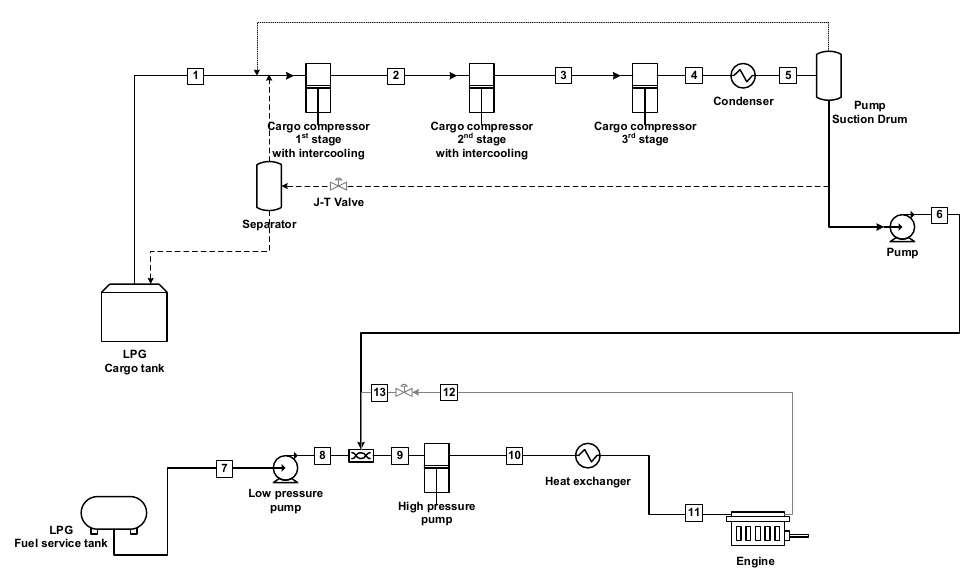
Figure 5. Process flow diagram (PFD) of the novel re-liquefaction and fuel supply systems.